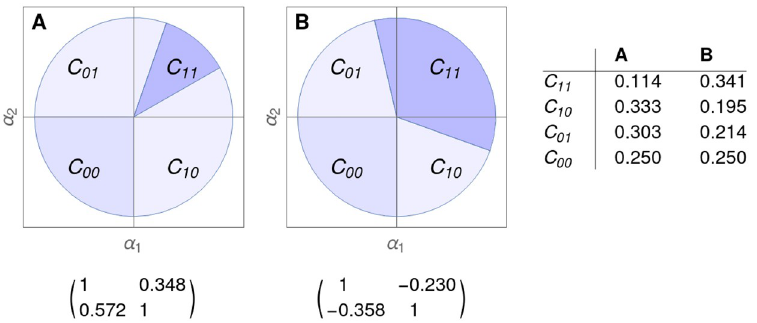
Fig 4. Description of cones for alpha parameters associated to 8 with 2 × 2 matrices as indicated. A. Competitive case. B. Cooperative case. Note that there are four regions C , i , j = 0, 1, each for the four possible stationary points. If α ij 2 C ij , the globally asymptotically stable point u � for (8) has the positive components pointed by ij , i.e., α 2 C 11 means that in u � ; u � > 0 : Note that borders of each cone are bifurcation lines, in the sense that a sudden attractor bifurcation 1 2 occurs when passing through this border. Moreover, inside each cone, there exist interesting zones marking